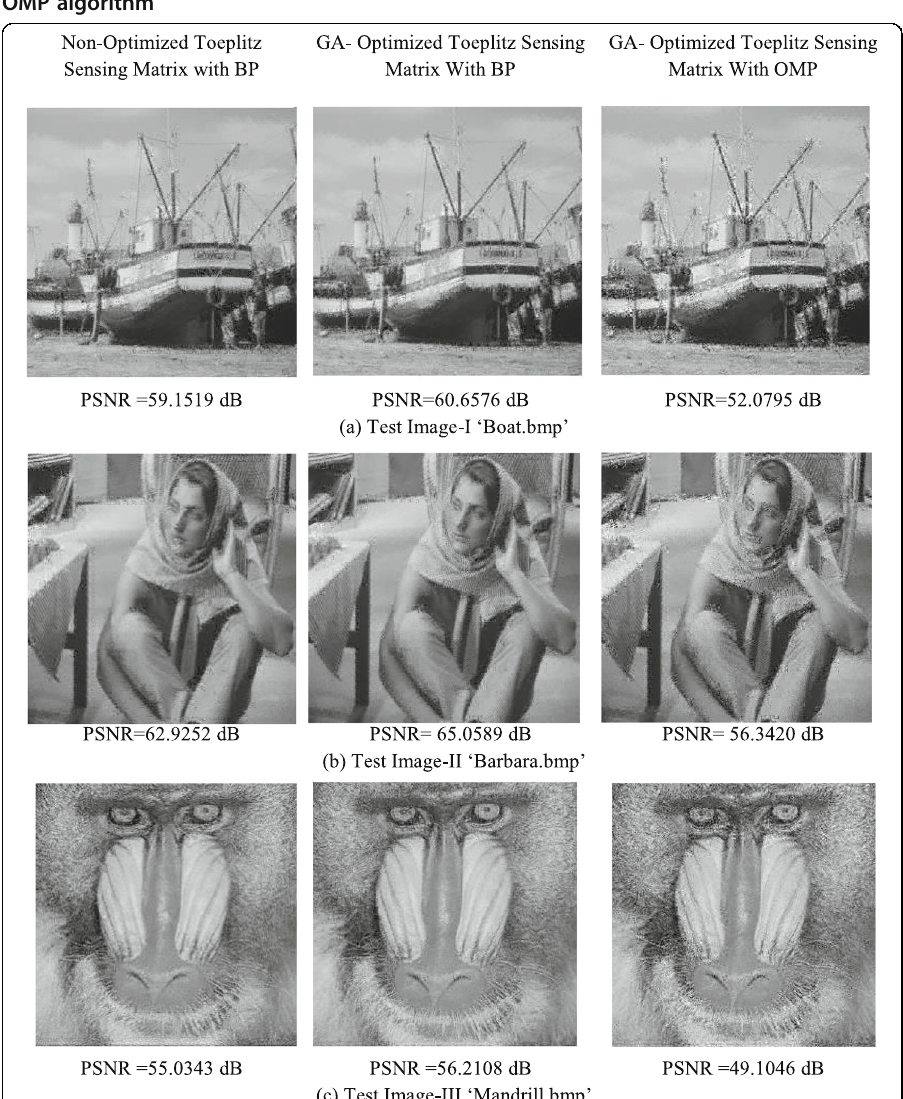
Fig. 16 Comparison between reconstructed test images using proposed GA-optimized sensing matrix with BP and OMP algorithm, for CR=0.5. a Test Image-I “ Boat.bmp. ” b Test Image-II “ Barbara.bmp. ” c Test Image-III “ Mandrill.bmp